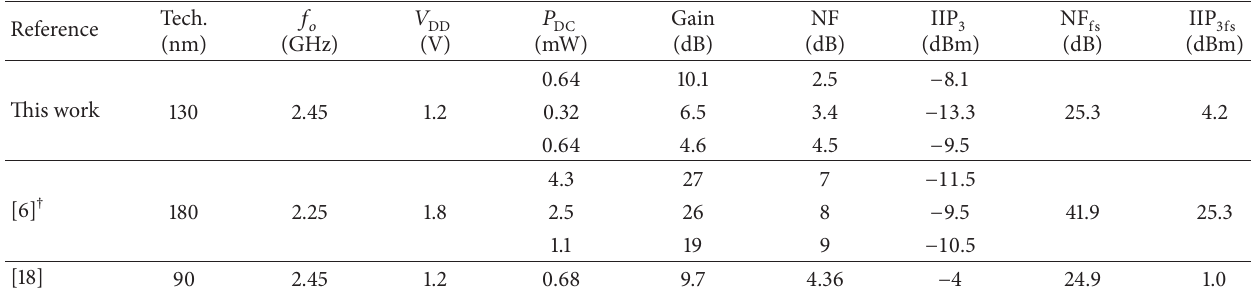
Table 4: Performance comparison of LNAs for IEEE-802.15.4